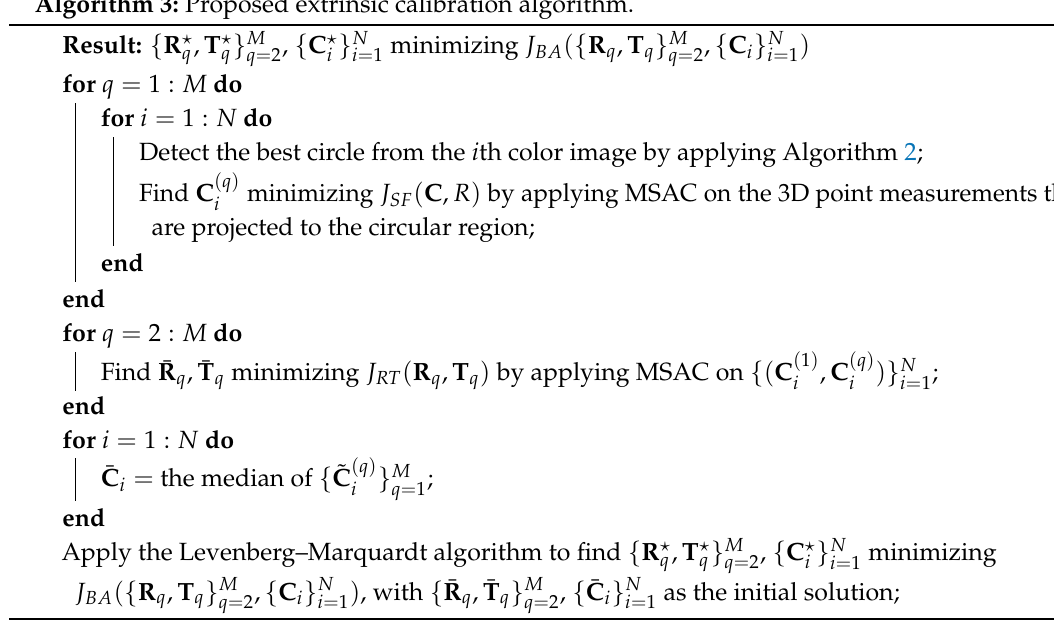
Algorithm 3: Proposed extrinsic calibration algorithm.